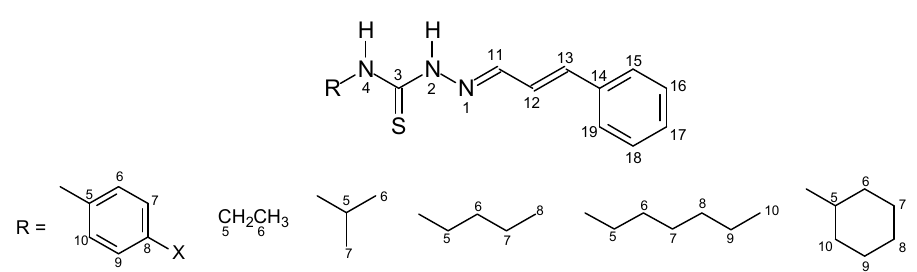
Figure 1. Cinnamaldehyde series